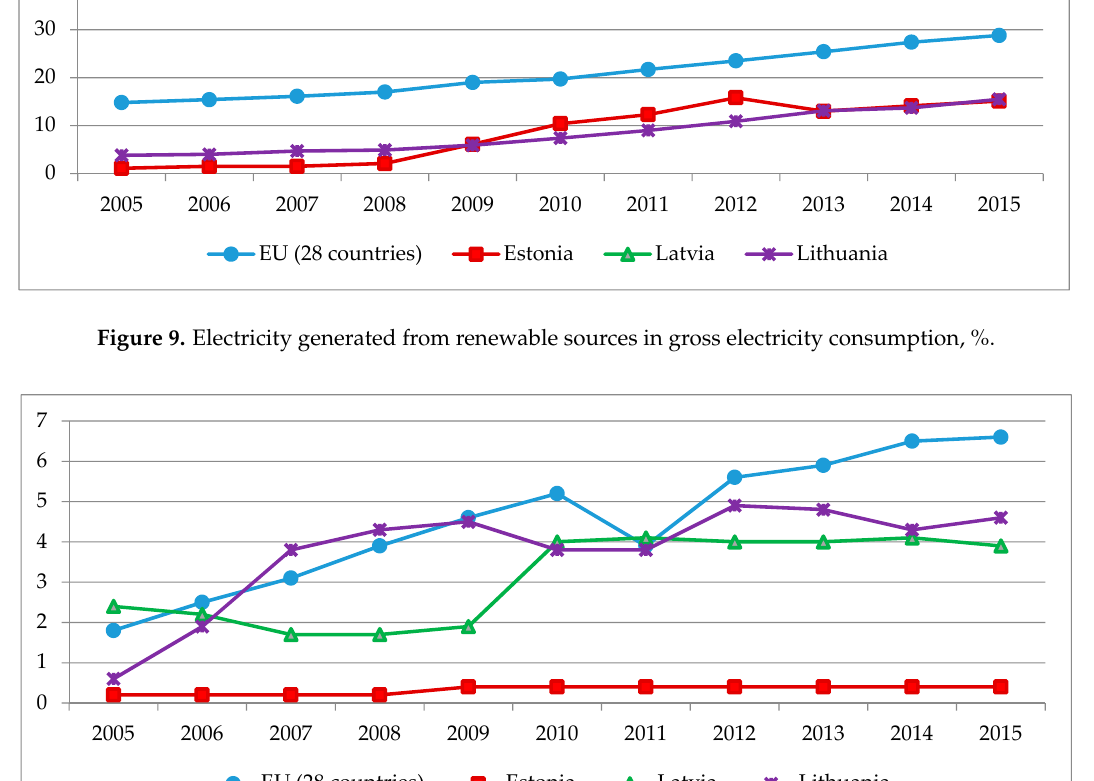
Figure 11. Combined heat and power generation as a percentage of gross electricity generation. Estonia has the lowest proportion of CHP in gross electricity production, which is also significantly lower than the EU average. Meanwhile, Lithuania and Latvia have higher proportions